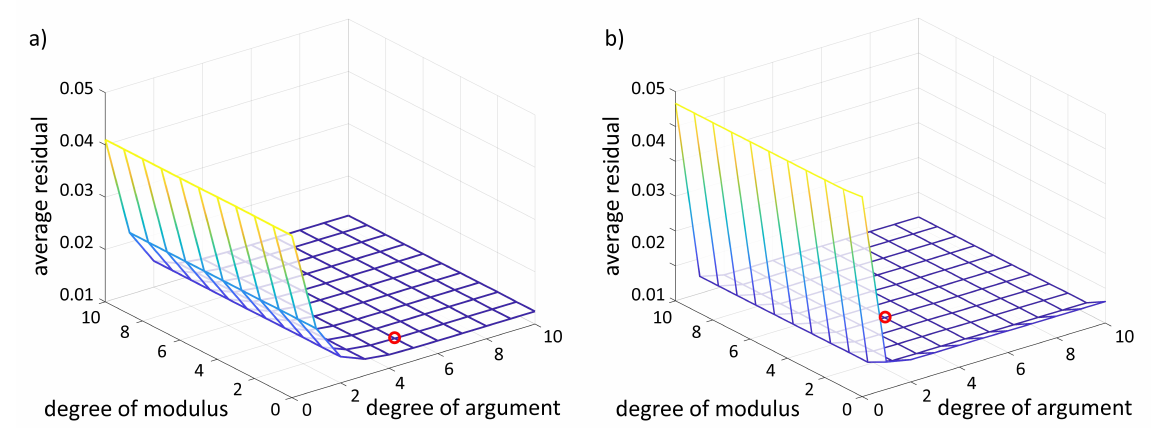
Figure 7. Average residual e (Equation (19)) of HI pp ( f ) over degree of fitting polynoma for the low frequency ( a ) and high frequency ( b ) test bench. The red circle marks the polynomial degree whose relative change of the residual is less than 1%.